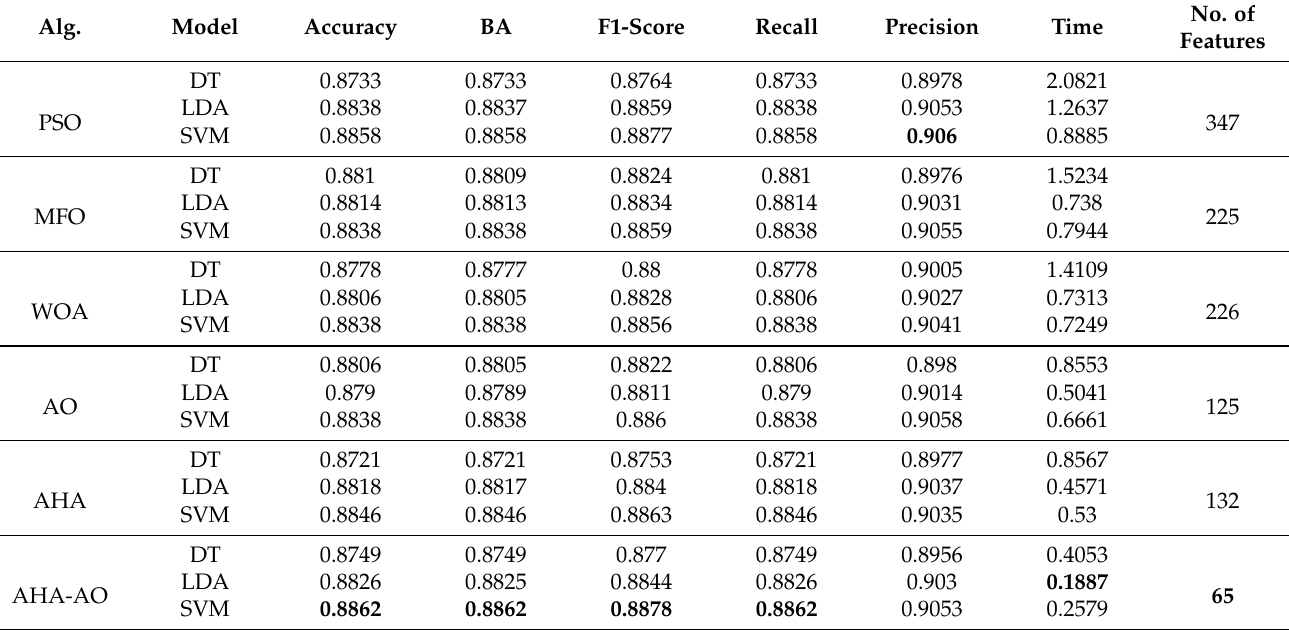
Table 7. Classification results of each feature selection optimization algorithm on the Blood-Cell dataset (bold refers to best